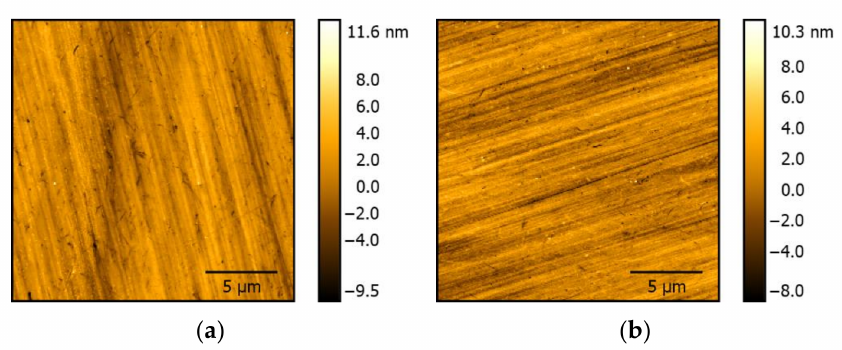
Figure 2. AFM images of the surface of HfSi x O y layers: ( a ) deposited at RT (Rq = 1.4 nm) and ( b ) deposited at 600 ◦ C (Rq = 1.4 nm).